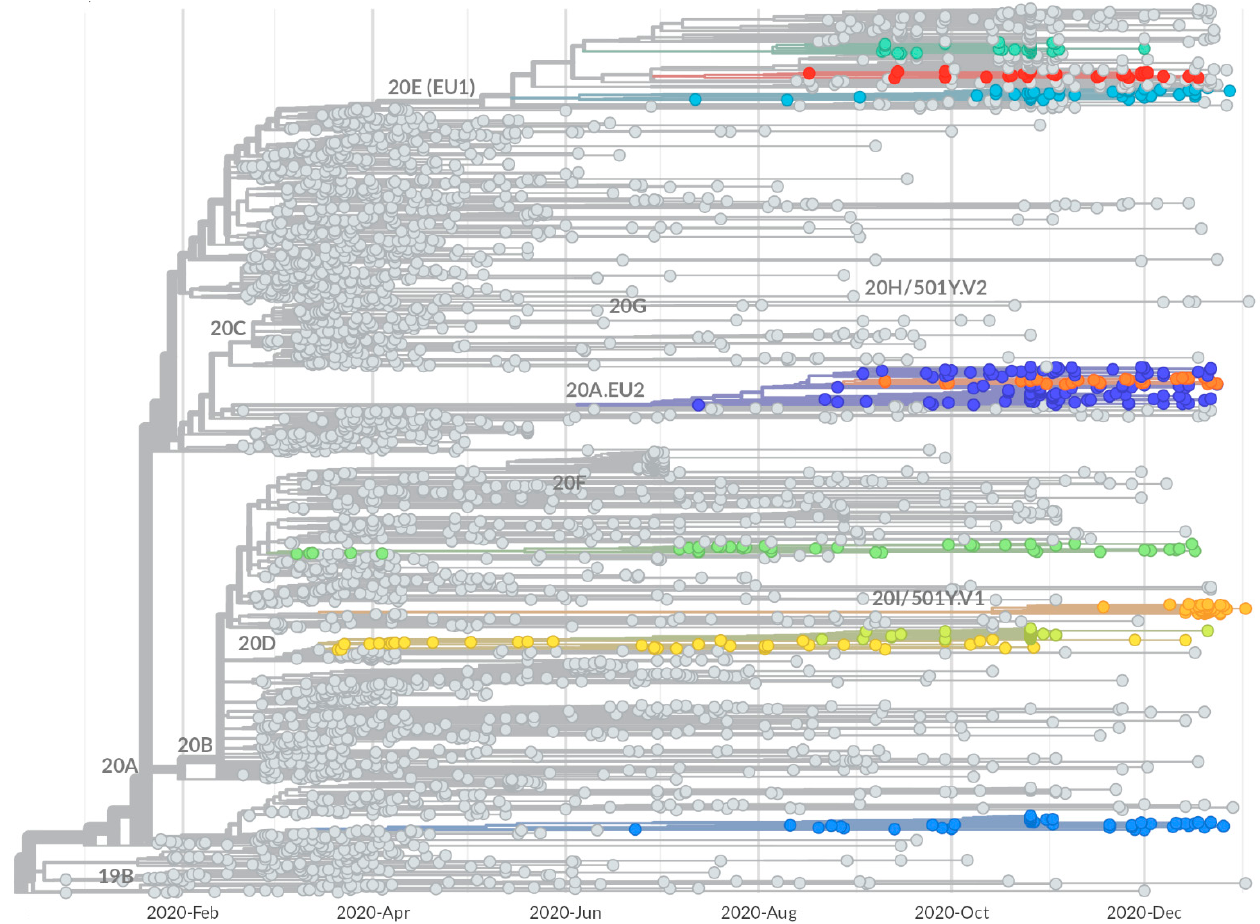
Figure 2. Growing subsets. The identified ten subsets are shown in the context of the phylogenetic tree, using colors. Subsets contained in a larger one are indicated by their names, separated by dash, as for 2–3, in which S2 is contained in S3. The occurrence of known clades is indicated by the labels near the top node of the corresponding sub-tree. The bottom bars indicate the time periods in which the Italian government implemented stringent (black) or relaxed (gray) mobility restrictions.